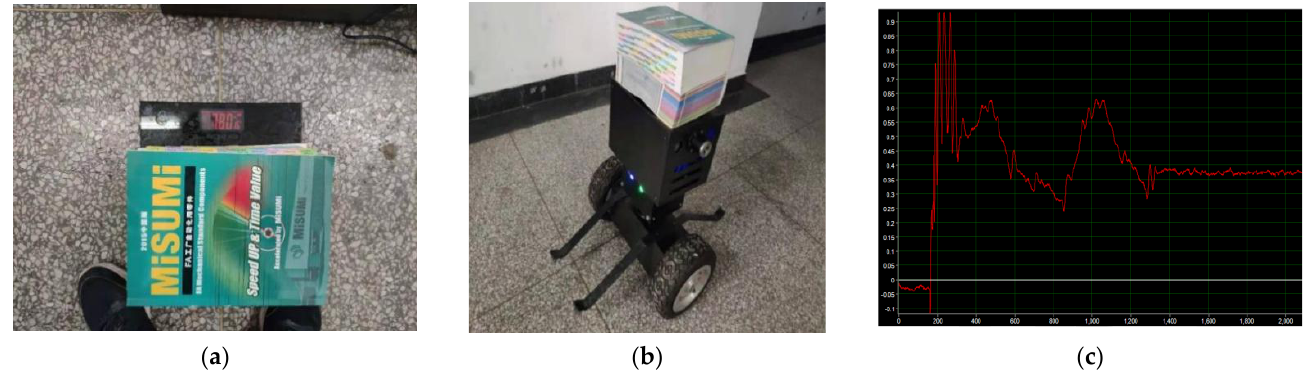
Figure 22. ( a ) Experimental load weighing. ( b ) Robot load experiment. ( c ) Waveform of robot atti- tude